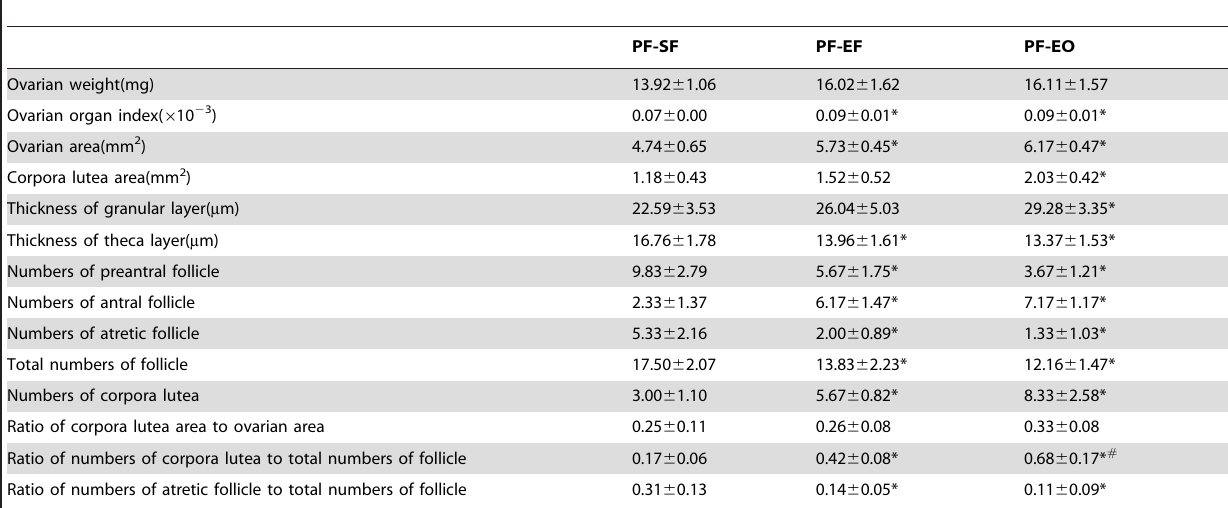
Table 4. Effects of exercise and diet on ovarian morphological parameters in obese PCOS